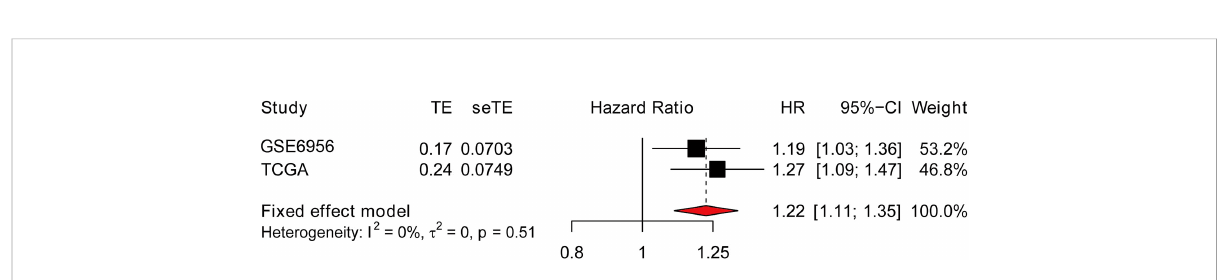
FIGURE 3 Forest plot of AP004608.1 expression with overall prognosis in PCa patients from TCGA and GEO